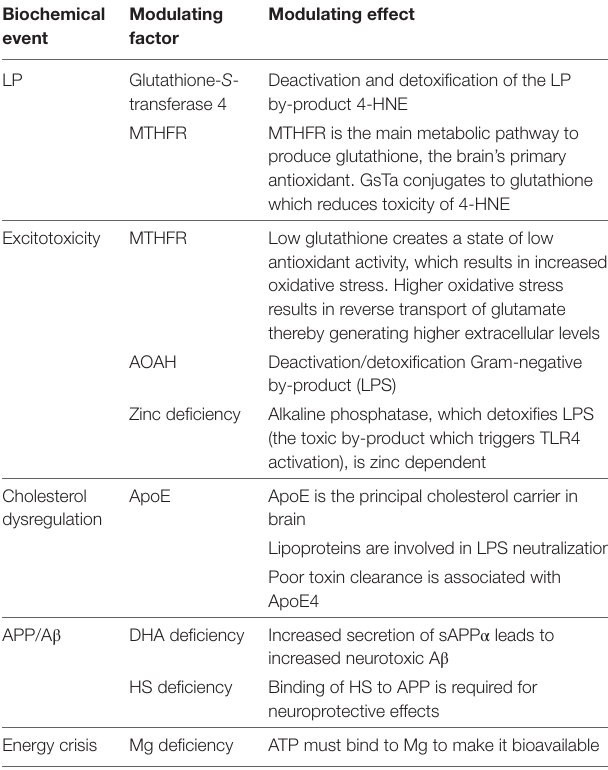
TABLe 1 | Modulating factors of